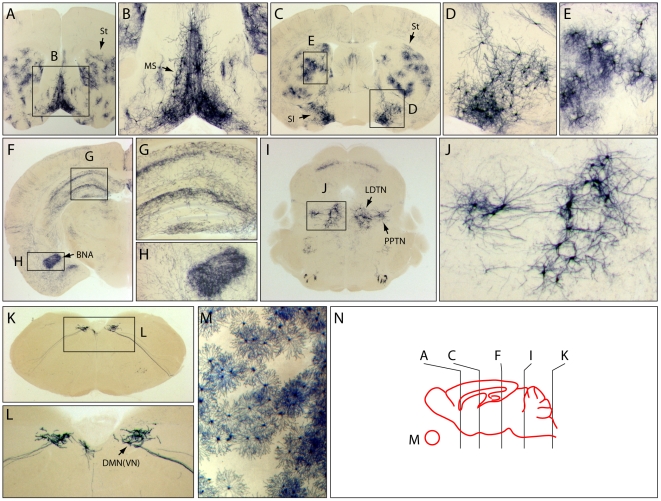
Survey of cholinergic neuronal morphologies and projections in the brain and retina of R26IAP;ChAT-IRES-CreER mice.Animals were injected with a single IP injection of 200 µg 4HT at P8. (A,C,F,I,K) 300 µm coronal sections at Bregma positions 1.2, 0, −2.5, −5.0, and −7.8, respectively, as shown schematically in (N). (B,D,E,G,H,J,L) enlargements of boxed regions. (M) In a flat mounted retina, AP-expression is present exclusively in starburst amacrine cells. In the absence of 4HT, retinas were devoid of AP+ cells. BNA, basolateral nucleus of the amygdala; DMN(VN), dorsal motor nucleus of the vagus nerve; LDTN, laterodorsal tegmental nucleus; MS, Medial septum; PPTN; pedunculopontine tegmental nucleus; SI, substantia innominata; St, striatum.